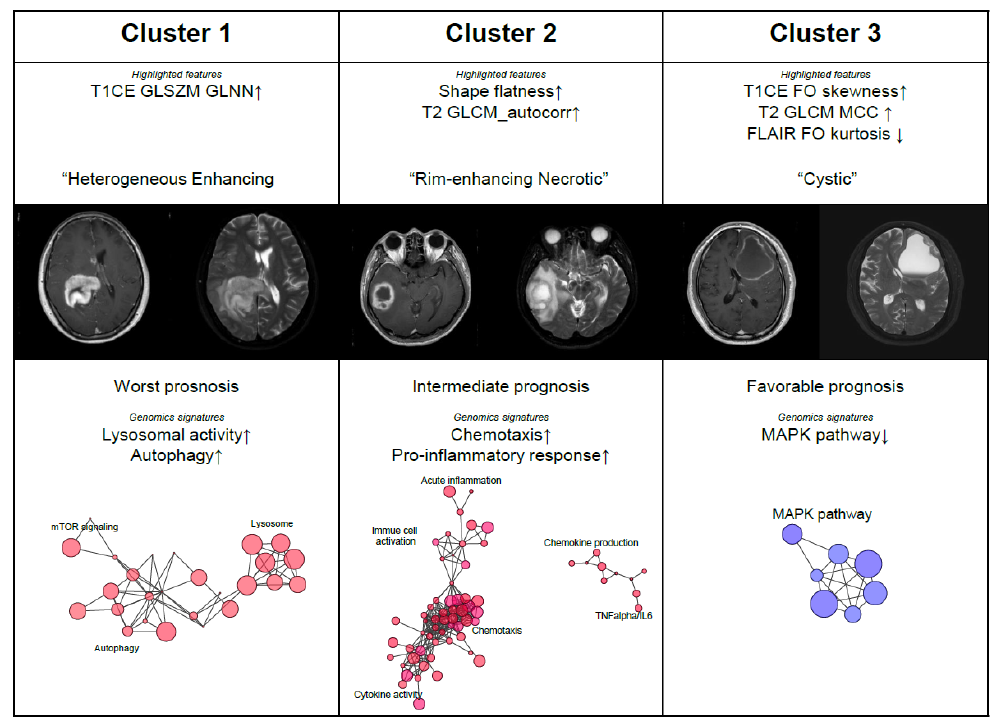
Figure 3. Radiomics subtypes present the distinguished imaging protypes of GBM tumors, which correlated well with genomic signatures. Quantitative radiomics features account for the gross finding of tumors on magnetic resonance (MR) images. Representative MR images as well as enriched genomic signatures of each radiomics subtype were presented.